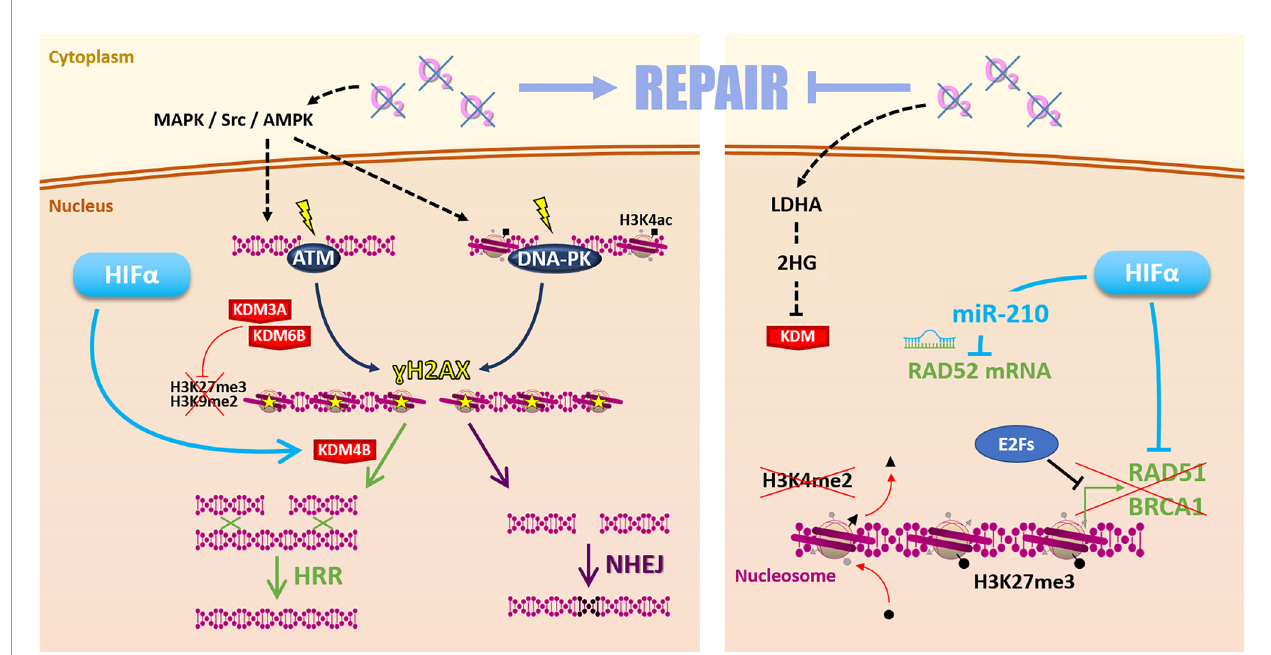
FIGURE 4 | Repair. Hypoxia can favor radiation-induced DNA damages repair (left side) by MAPK/Src/AMPK-dependent ATM and DNA-PK activation. Hypoxia- induced modulation of KDM3A, KDM6B, and KDM4B expression changes the epigenetic landscape favoring DSBs repair by HRR or NHEJ. However, low oxygen levels can also affect the Repair (right side) notably via 2-hydroxyglutarate-dependent KDM inhibition. Moreover, HIF a and E2Fs inhibit HRR-related genes RAD51 , BRCA1 expression. Hypoxia-induced epigenetic changes (as loss of H3K4me2 and gain of H3K27me3 marks) inhibit these genes ’ expression. HIF a can also inhibit RAD52 mRNA through the